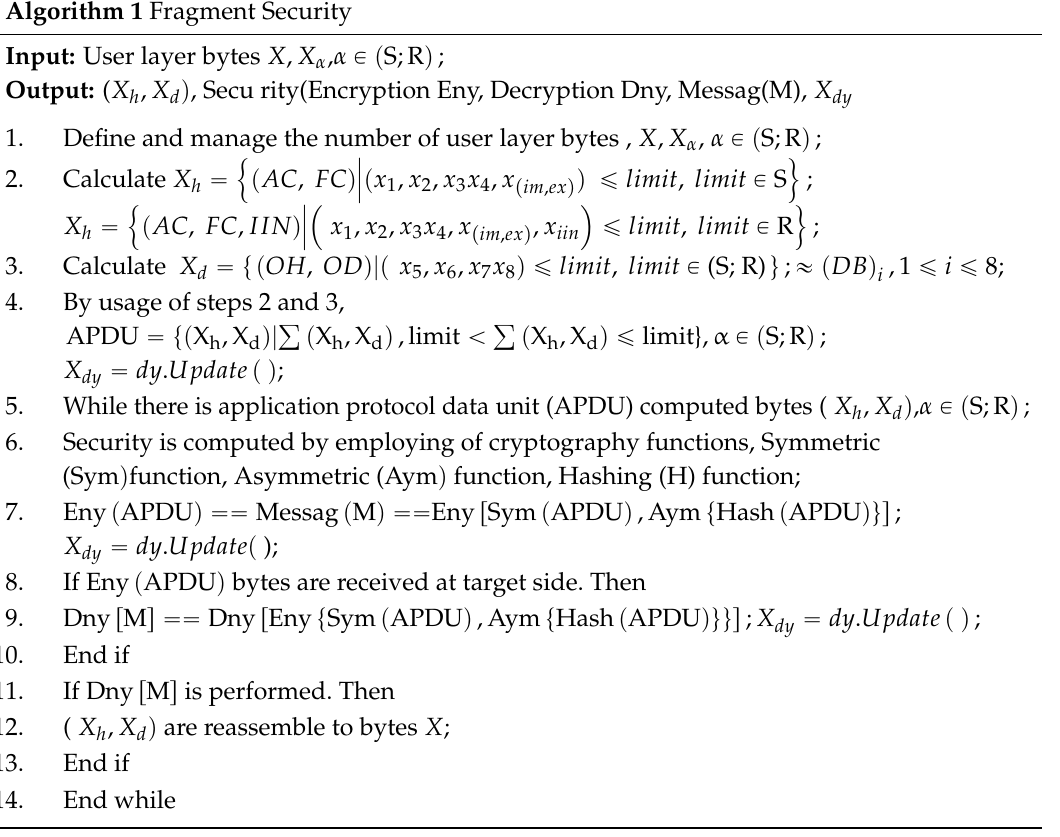
7. Algorithm: Pseudo-Code Computing of Fragment with Security Algorithm 1 Fragment